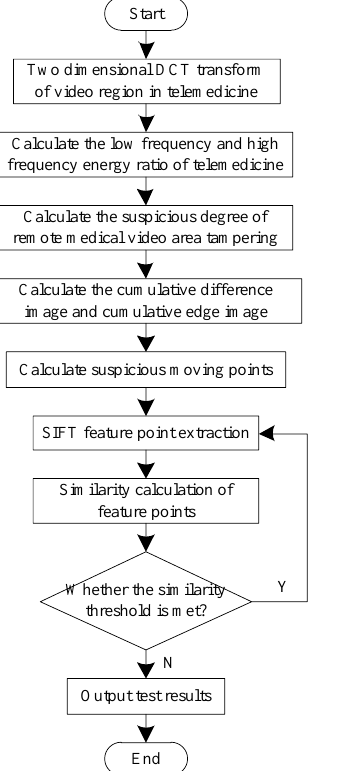
Figure 4. Screenshot of the original monitoring video image of the telemedicine